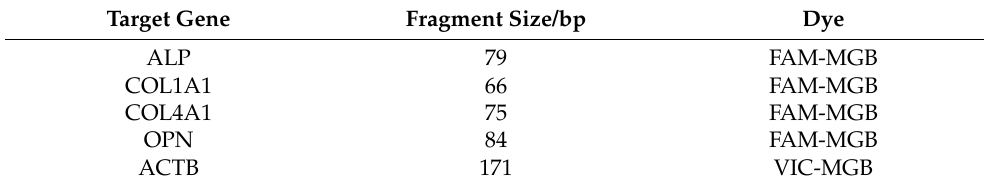
Table 1. A summary table of the primer sequences used for RT-qPCR. Target